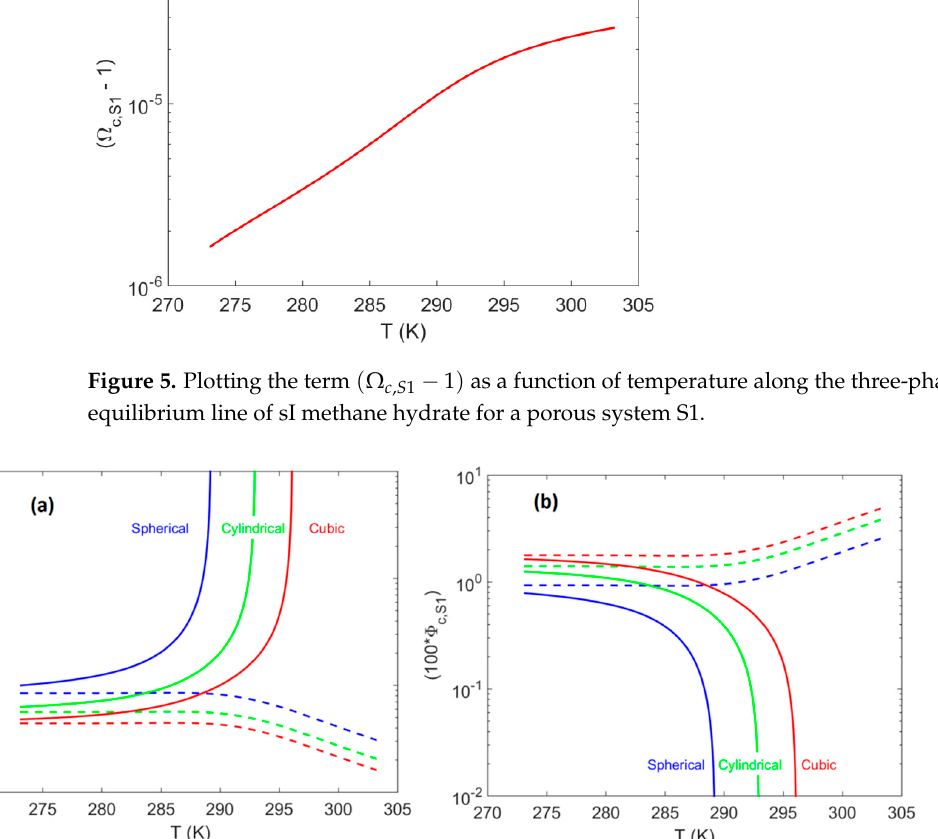
r , plotted as a function , 1 pc S